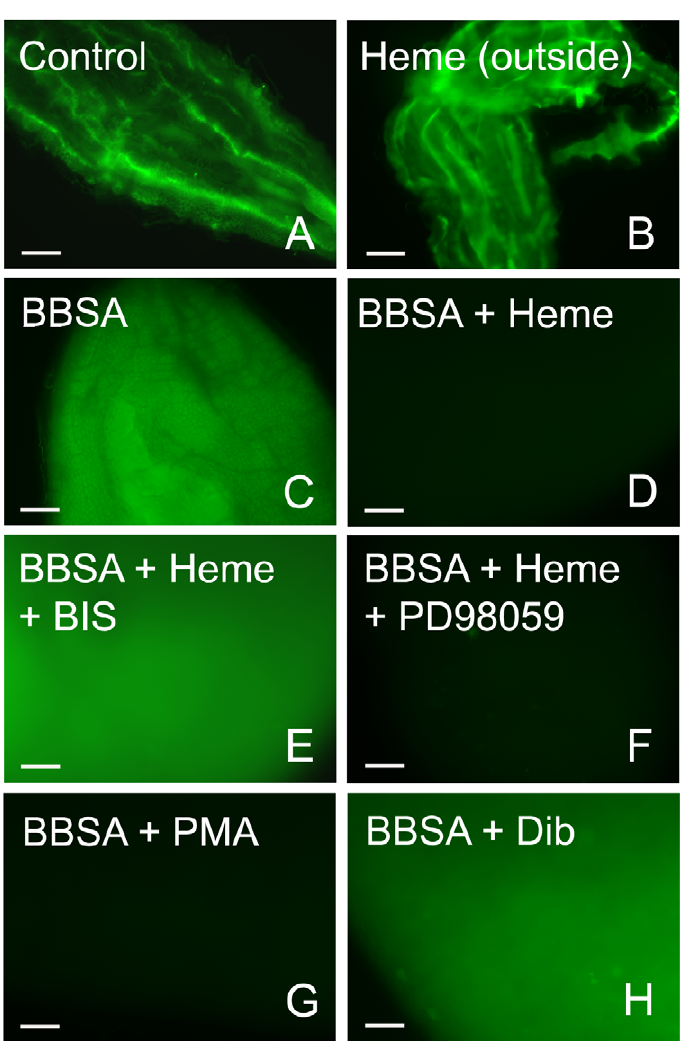
Figure 4. Heme-induced inhibition of ROS is mediated by PKC. ROS signal from the midgut under different conditions was evaluated. (A) Sugar-fed mosquitoes (B) Sugar-fed midguts incubated with heme (20 m M) added in the culture medium. In Figures C–H, female mosquitoes were fed with BBSA supplemented with different chemicals as indicated and dissected immediately after feeding. (C) BBSA alone; (D) BBSA + heme (20 m M); (E) BBSA + heme (20 m M) + BIS (10 nM) (PKC inhibitor). (F) BBSA + heme (20 m M) + PD98059 (50 m M) (MAPK inihibitor). (G) BBSA + PMA (100 ng/ ml) (PKC agonist). (H) BBSA + dibutyryl-cAMP (50 m M) (PKA agonist). These fluorescent images were acquired using the same microscope setup to allow direct comparison of signal intensities. Representative images are